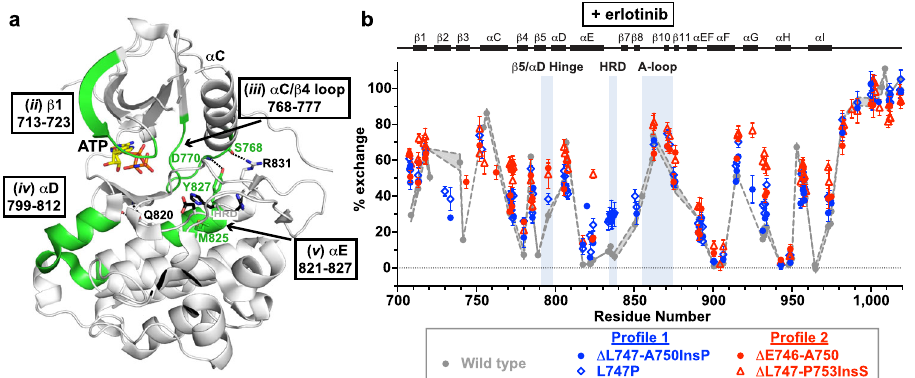
Fig. 5 | Location of peptides with increased exchange, and dampening by erlotinib. a The regions corresponding to peptides ii , iii , iv , and v in Fig. 4c are highlighted in green in the structure of wild type EGFR (PDB ID: 7KXZ), with ATP (sticks)positionedasinFig.4b.Theseregionsallshowincreasedexchangeinpro fi le 2 variants, and surround the ATP-binding site. Interactions between helices α E and α C mediated by the Y827 and R831 side chains and S768 and D770 main chain atoms, allowing α C/ α E communication, are shown as dotted lines. Q820, which interacts with the β 7/ β 8 hairpin, is also shown, as is the M825 side chain in α E that contacts the histidine of the catalytic loop ’ s HRD motif. b Percent exchange data in